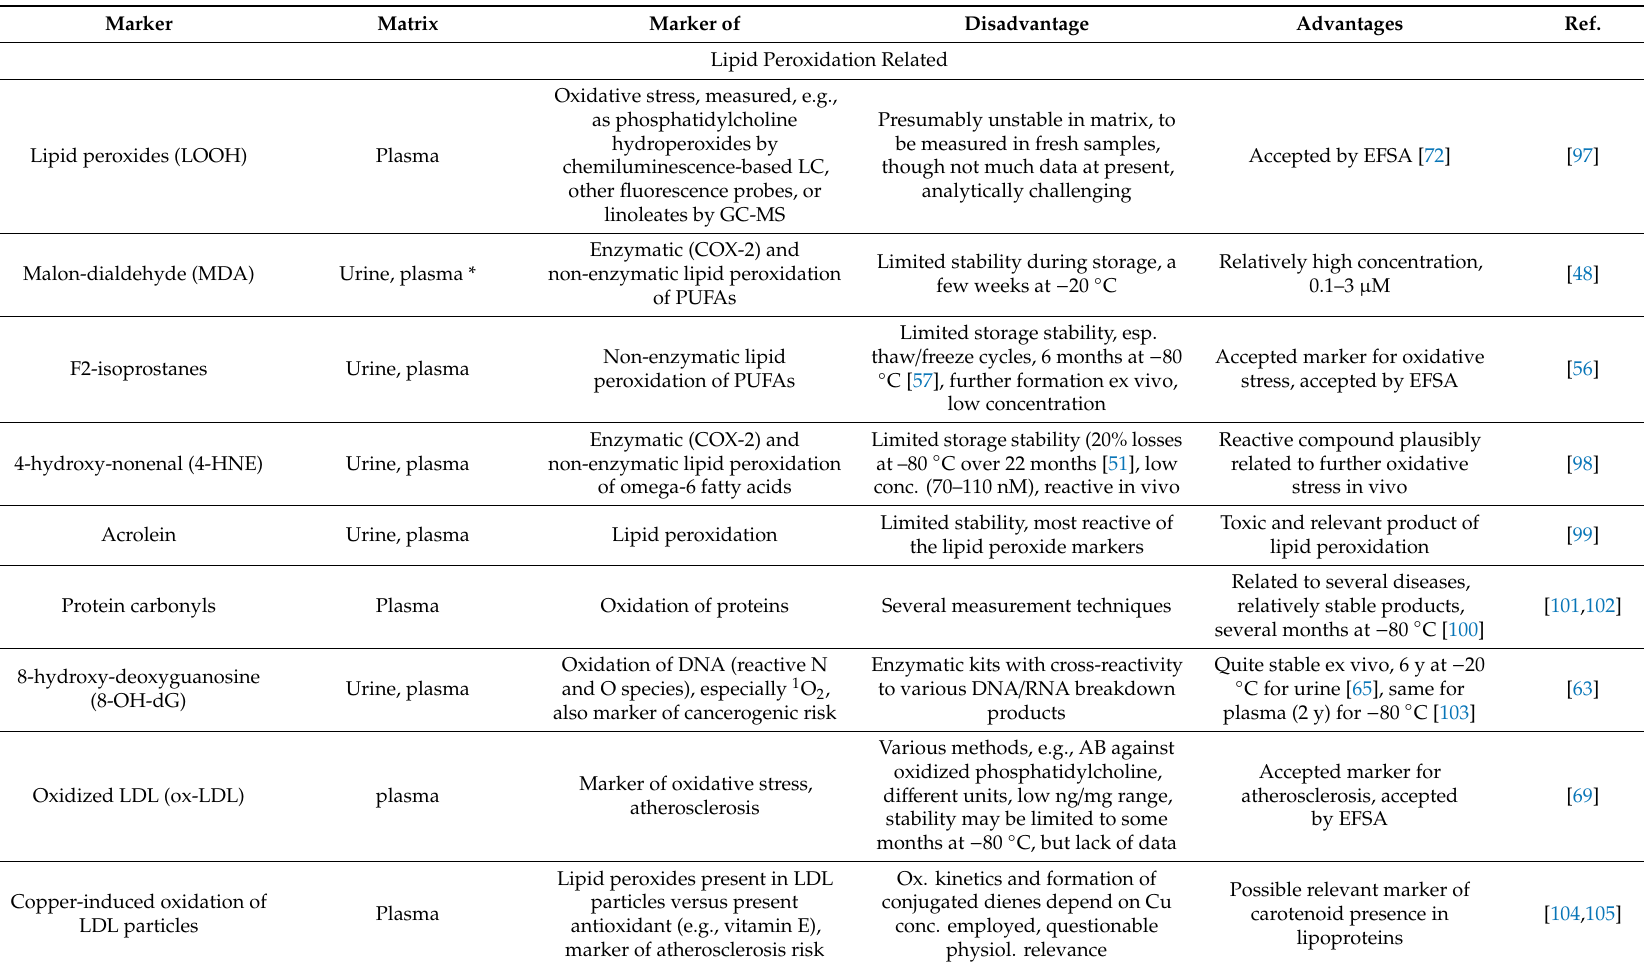
Table 2. Selected markers of oxidative stress as well as commonly employed markers of inflammation in human studies assessing mid- to long-term e ff ects of